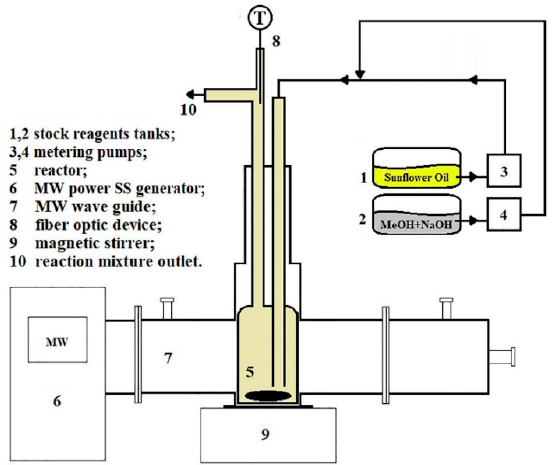
Figure 3. Scheme of mono-mode MW reactor for biodiesel synthesis [16].